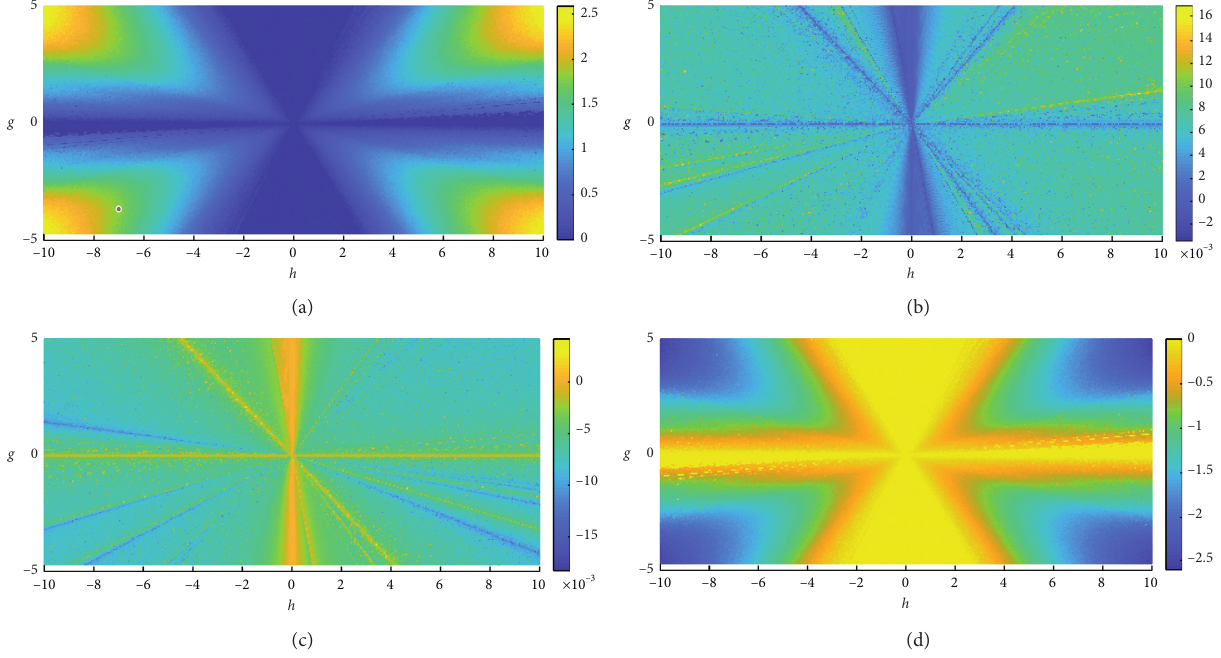
Figure 13: Dynamical evolution map of Case 2 system with h ∈ (− 10 , 10 ) , g ∈ (− 5 , 5 ) . (a) LE1. (b) LE2. (c) LE3. (d) LE4.